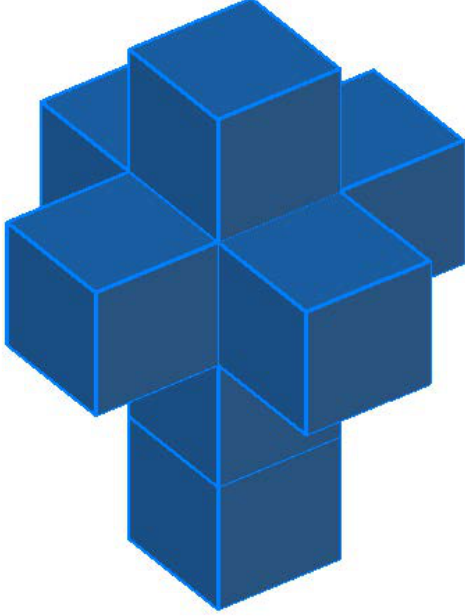
Figure 62: Unfolding of a tesseract in three-dimensional space.